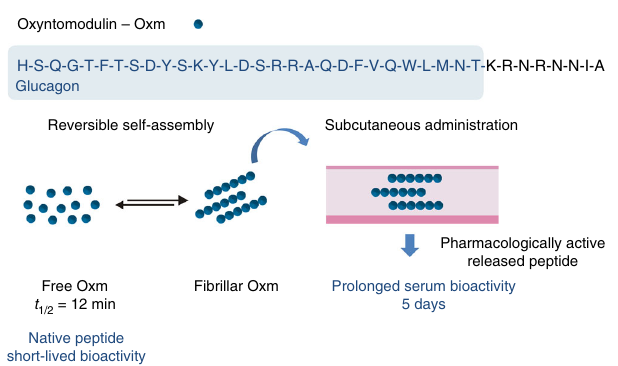
Fig. 8 Reversible peptide self-assembly to control and prolong Oxm bioactivity in vivo. The proglucagon-derived peptide hormone Oxm has limited clinical application owing to its short half-life of 12min in humans. Oxm readily self-assembles into nano fi brils which subsequently dissociate under physiological conditions to release pharmacologically active